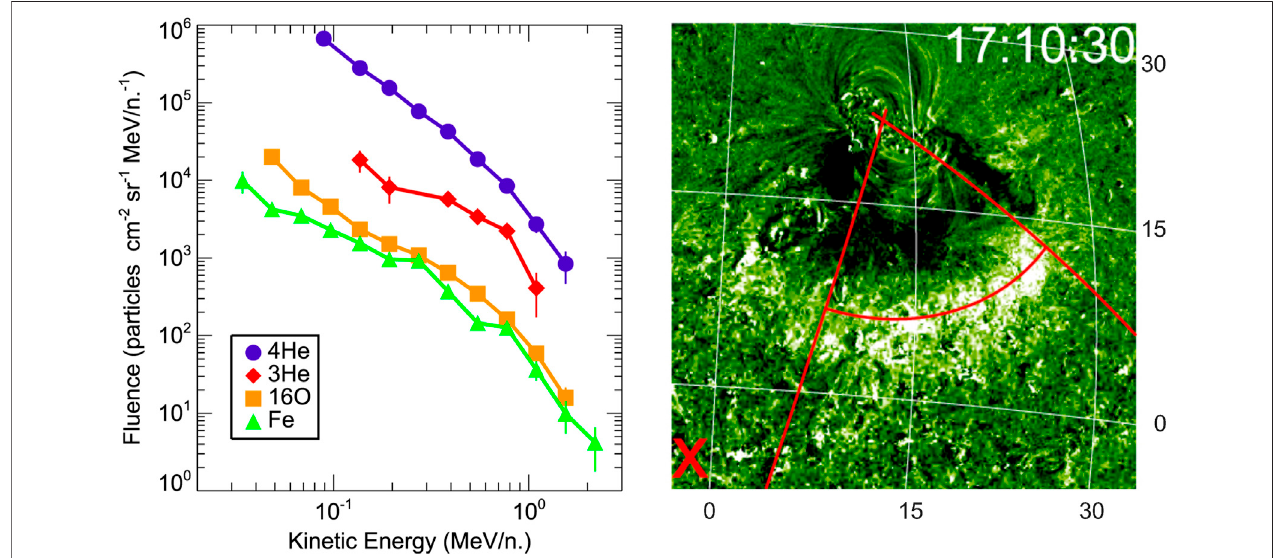
FIGURE2| The2010January 26ISEP event. Left:ACE ULEIS energy spectra forselectedion species. The 4 He, O,and Fespectrashow power law form; the 3 He spectrum isunambiguous. Adapted from Bu č íket al.(2015). The 3 He/ 4 He and Fe/O at 0.385 MeV/nucleonare ∼ 0.13 and ∼ 0.6, respectively. The 3 He/ 4 He is consistent with the median value of 0.385 MeV/nucleon 3 He/ 4 He ∼ 0.12 in class-1 events. The Fe/O is somewhat lower than the typical value in ISEP events ( ∼ 0.95 at 0.385 MeV/ nucleon;Masonetal.,2004).Right:STEREO-AEUVI195 Å 5-minrunningdifferenceimageoftheeventsolarsourceshowingacoronalwave.AdaptedfromBu č ík et al. (2015).Two red curves, passing through thesource active region (AR), outlinethe propagation sector where the wavespeed wasdetermined. Thered curve along the wave front outlines an arc centered on the AR. The red cross marks the ACE magnetic foot-point. The B-class X-ray fl are was measured in the event.